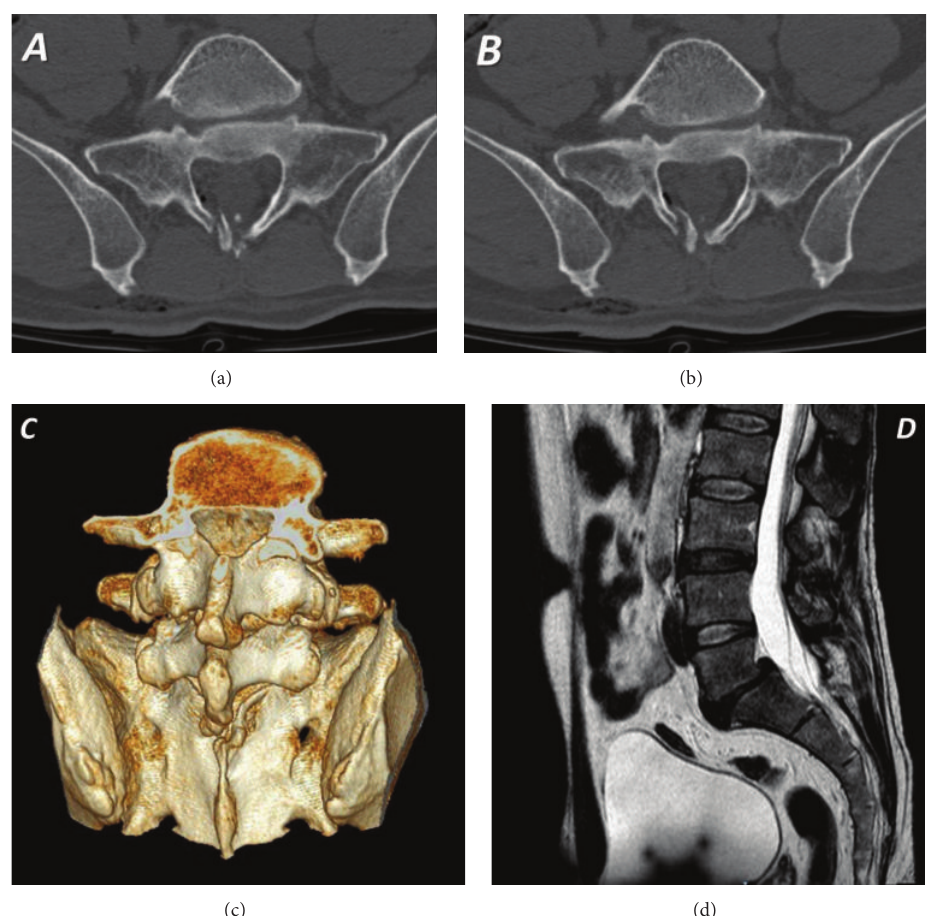
Figure 2: Lumbosacral CT scan ((a), (b), (c)) and RMI (d) showing a multifragmented fracture of the S1 lamina, with air bubbles in the epidural space.